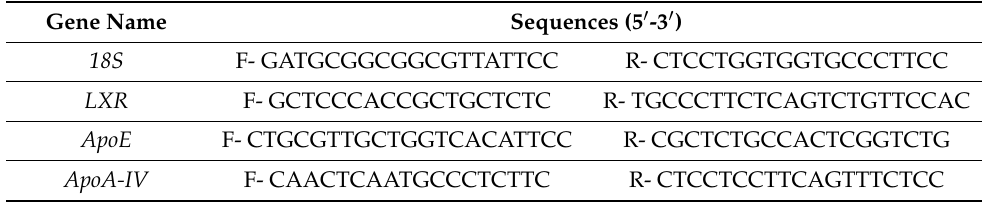
Table 1. Sequence of the primers used in this